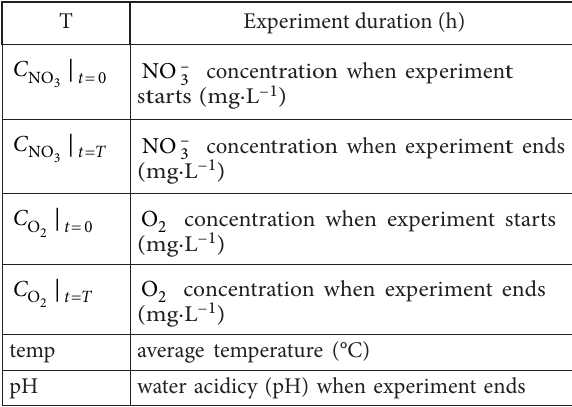
Table 1. The parameters of